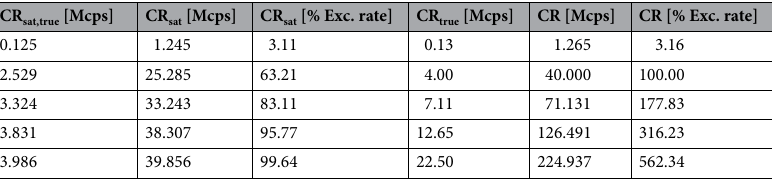
Table 2. CRs used for experimental study before (CR sat,true ) and after (CR true ) correction (first and fourth columns). Equivalent CRs obtained by summing up the 10 repetitions before (CR sat ) and after (CR) correction (second and fifth columns). Percentages of the excitation rate before (CR sat percentage) and after (CR percentage) correction (third and last